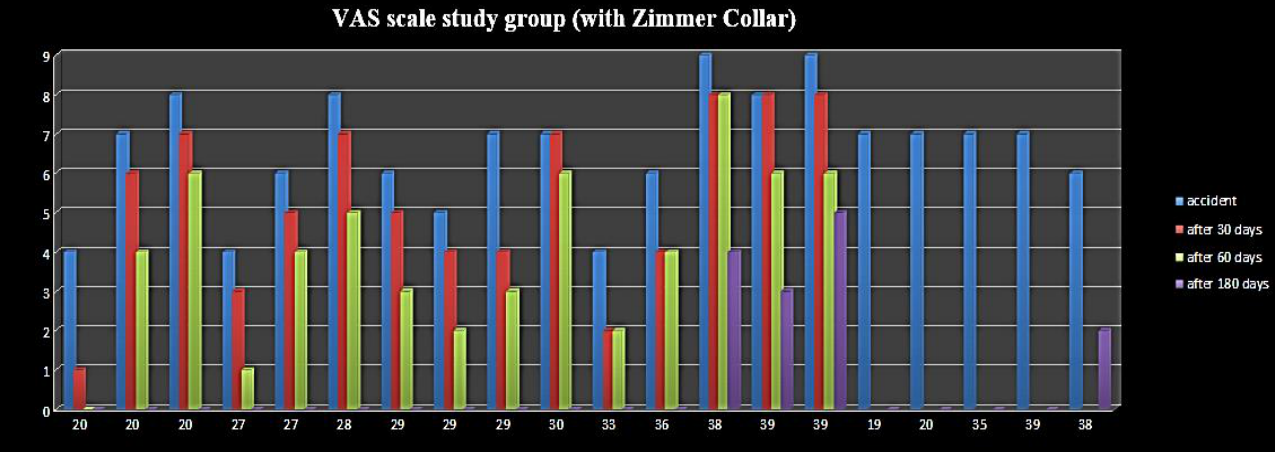
Figure 1. VAS scale study group (with Zimmer Collar).